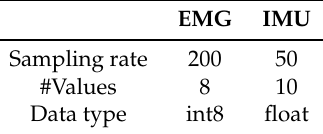
Table 1. Overview of the sensors and data types. EMG: electromyography; IMU: inertial measurement unit.